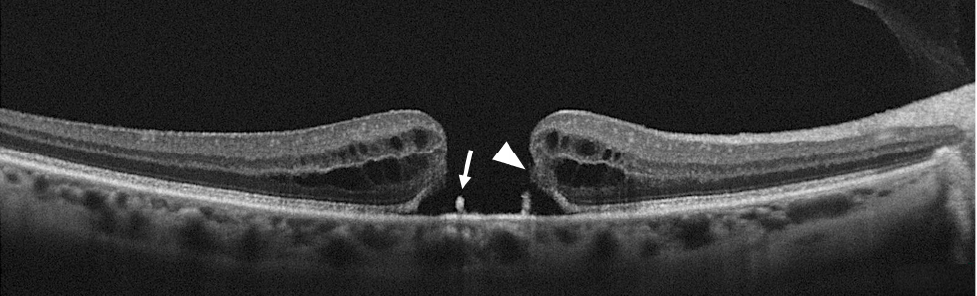
Figure 4. Optical Coherence Tomography (OCT) scan showing photoreceptor outer segment disruption at the macular hole borders (arrowhead). Supra − retinal pigment epithelium hyperreflective granular deposits are also visible at the base of the hole (arrow).